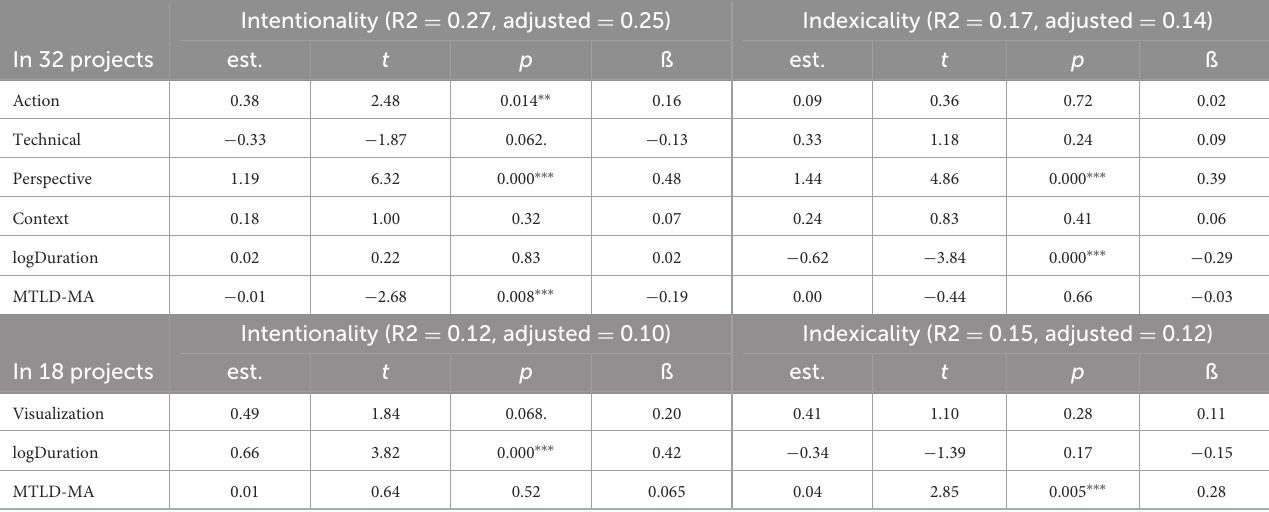
TABLE 4 Statistics for regression models predicting Intentionality and Indexicality from rated characteristics, duration, and lexical diversity, in all 32 projects and a subset of 18 projects integrating visualization. Intentionality (R2 0.27, adjusted = =